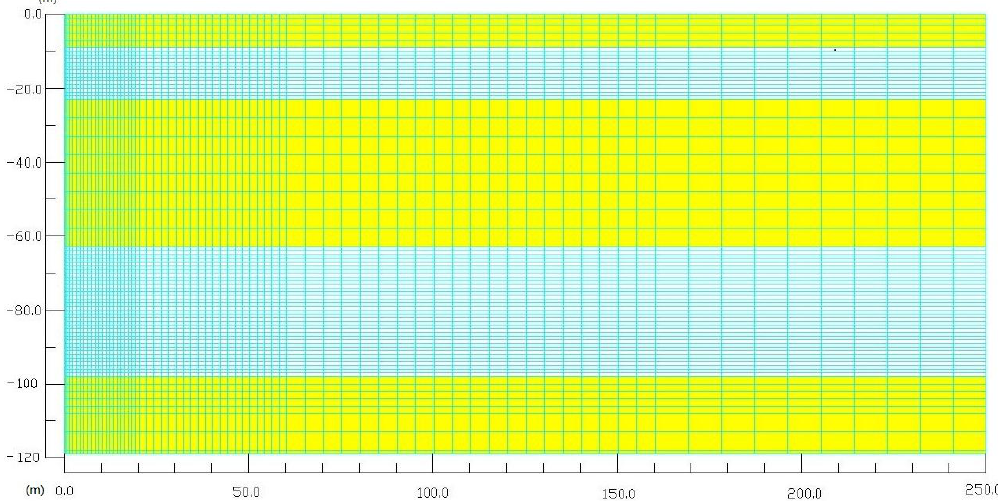
Figure 5. Domain discretization of the hydrate reservoir in the simulations.